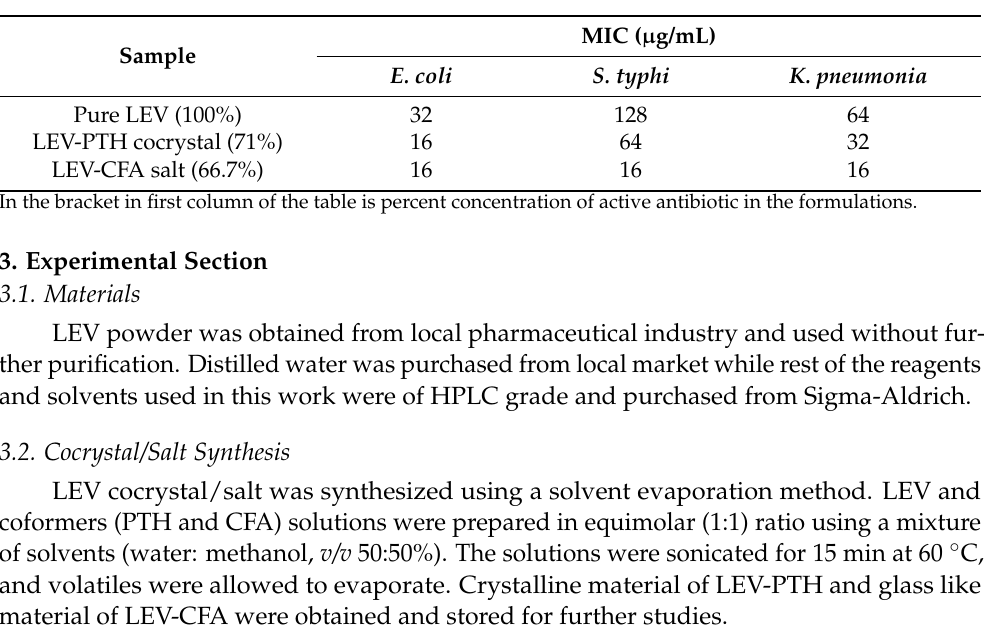
Table 3. MIC values of pure LEV, cocrystal and amorphous salt against different bacterial strains. Sample